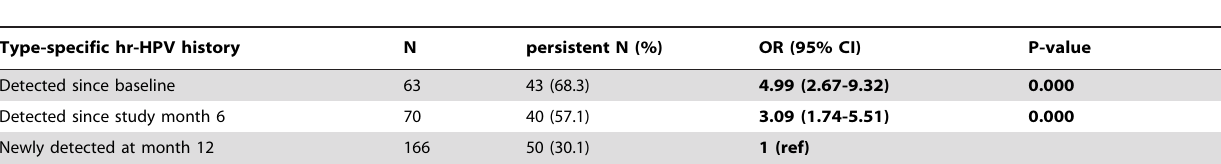
Table 4. Influence of the duration of type-specific hr-HPV detection on persistence in 2 nd study year.